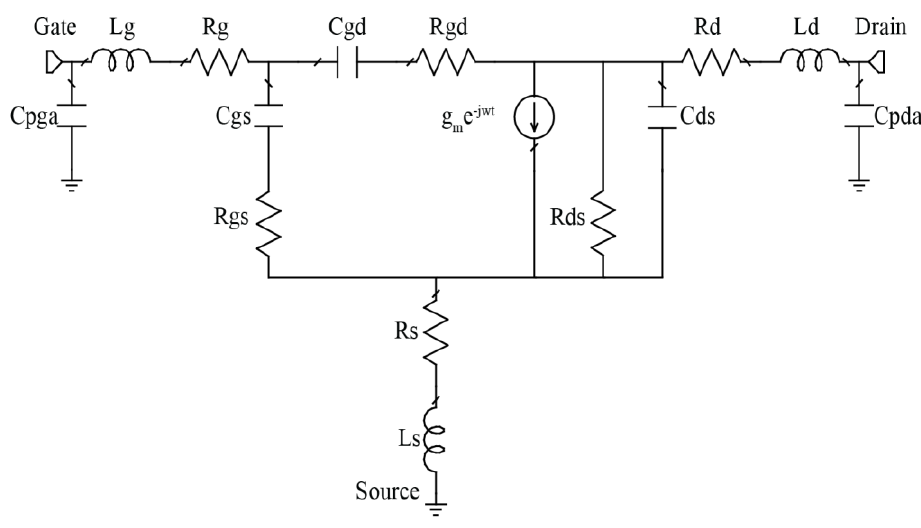
Fig. 1. Small-signal equivalent circuit of a GaAs